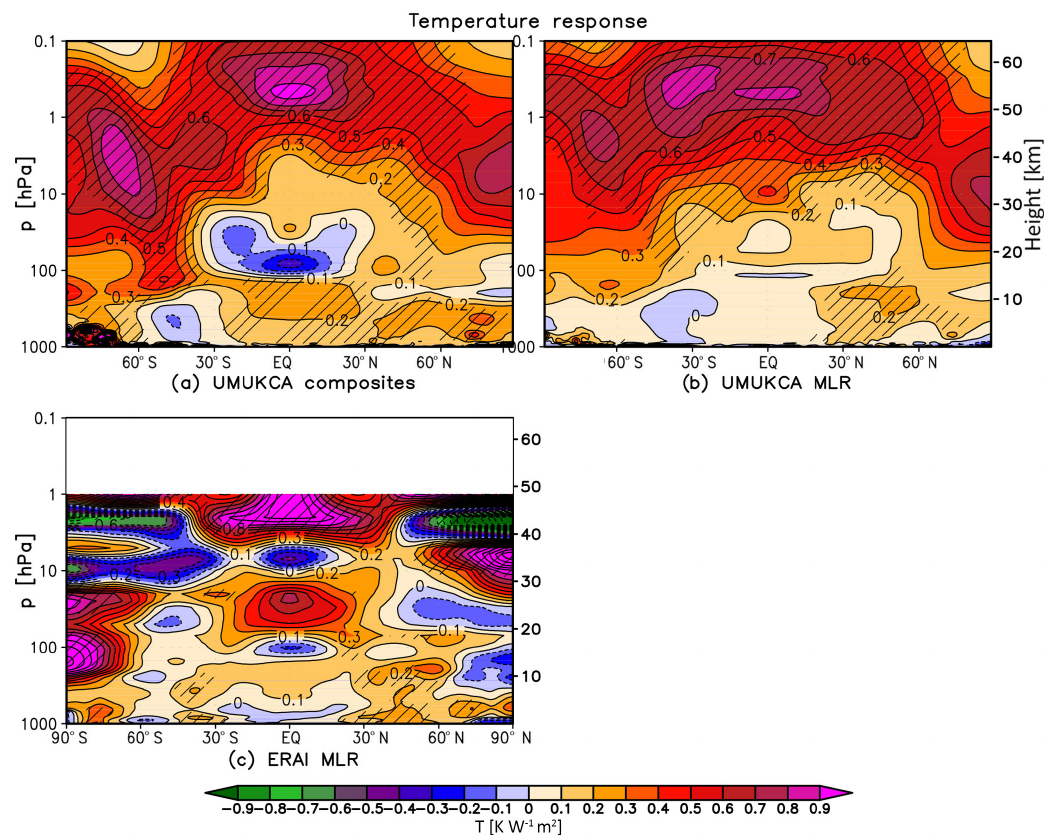
Figure 3. Yearly mean zonal mean temperature response (KW − 1 m 2 ) in UM-UKCA derived using composites (a) and MLR (b) , as well as in ERAI derived using MLR (c) . Shading indicates statistical significance on the 95% level ( t test). Contour spacing is 0.1KW − 1 m 2